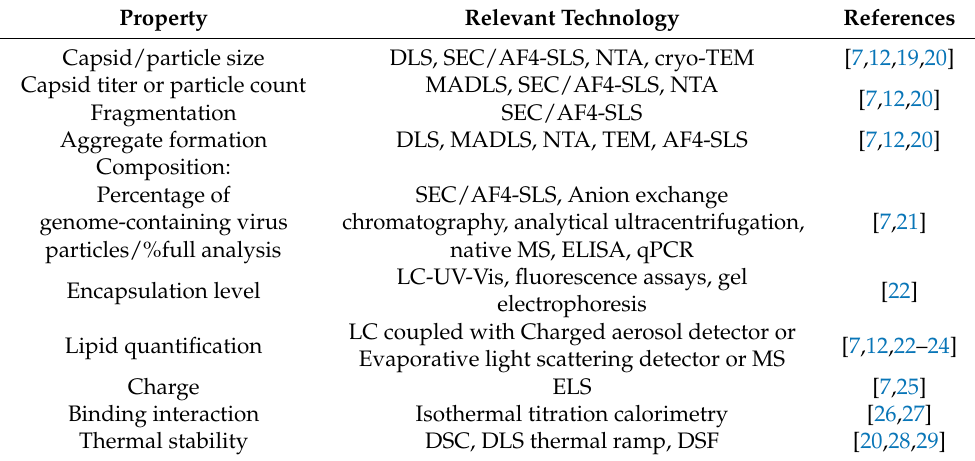
Table 1. Technologies used in characterization of viral and lipid-based vectors